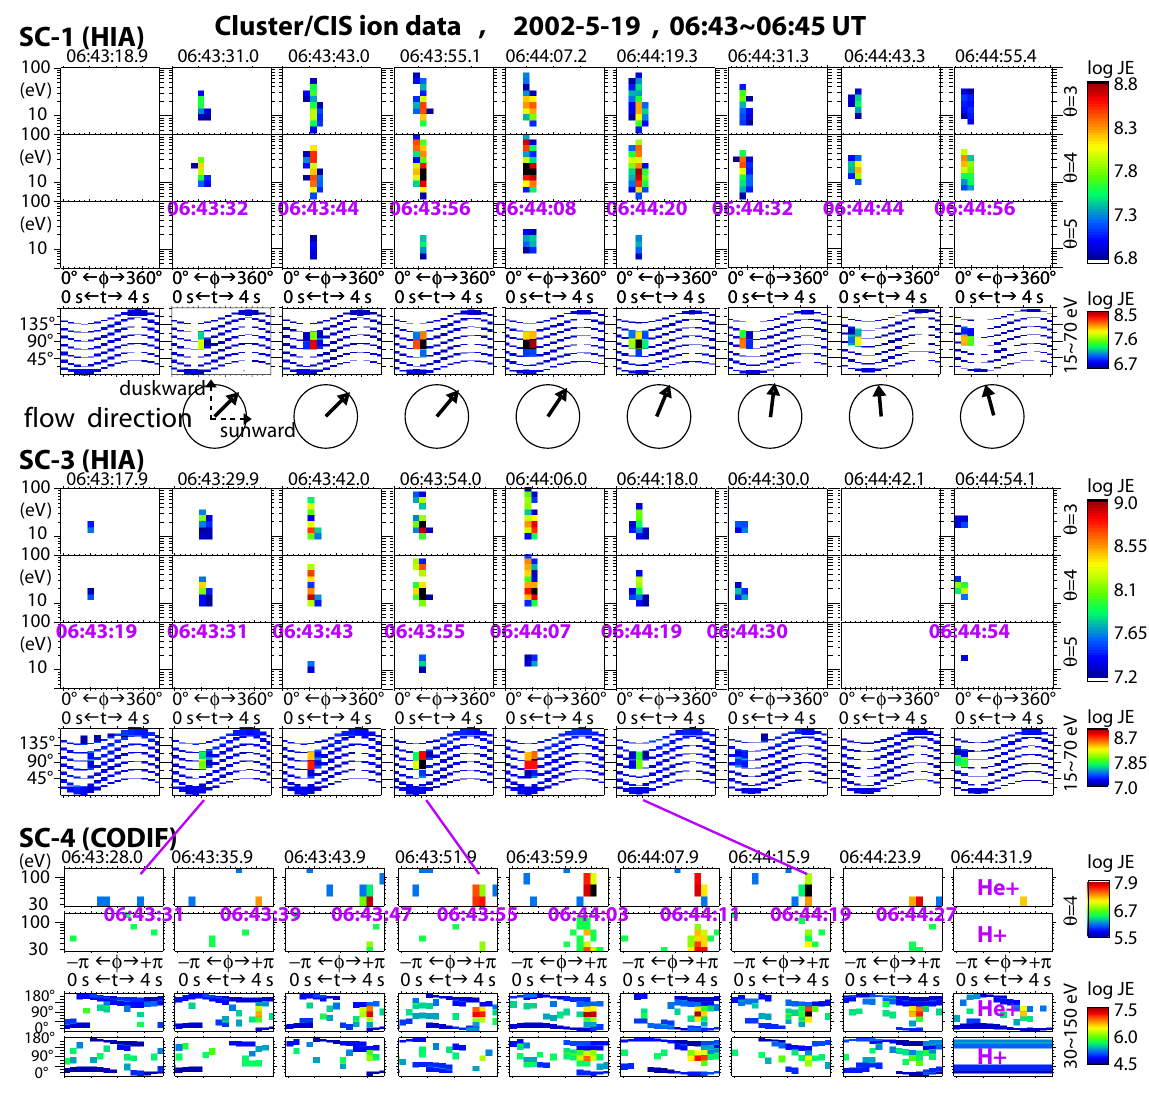
Fig. 7. Highest resolution plots of differential energy fluxes (keVcm − 2 s − 1 str − 1 keV − 1 ) of low-energy ions observed by CIS during data (bottom 4 rows) corresponding to low-energy part of Fig. 1b. Data is not averaged over spin (4s) or different sectors (polar angles). During this period, HIA took data every third full-spin (taking data 4s and idle 8s) for both SC-1 and SC-3, while CODIF took data less frequently except for SC-4 which took data every other full-spin (taking data 4s and idle 4s). For each 4-s measurement, UT corresponds to the spin phase angle (azimuthal angle, which is 180 ◦ off between HIA and CODIF), and the starting UT of each 4-s measurement is displayed at the top of panels for each SC. The top three rows are energy-time spectrograms of 4 ∼ 100eV ions from SC-1 observed at sectors with non-zero flux beyond the noise level (sectors 3, 4, and 5) among total 8 sectors. Sector 1 is looking at nearly north, i.e., detecting ions traveling nearly along the geomagnetic field from north to south. Sectors 4 and 5 correspond to nearly perpendicular direction to the geomagnetic field. The UT under the enhanced counts inside panels corresponds to the UT when these counts are actually detected (in only 2 ∼ 3 directions out of 16 azimuthal directions). The 4th row is energy-averaged (15 ∼ 70eV) pitch angle-time (azimuth) spectrogram, where the blue thick lines denote the direction of boundaries between neighboring sectors (top and bottom sectors corresponds to sectors 1 and 8, respectively). The pitch angle of each sector slightly modulated because the spin axis is not exactly 90 ◦ from the magnetic field direction. The enhanced counts are registered in nearly the same azimuthal direction, and this flowing direction in the geophysical coordinate is illustrated below the 4th row. The middle four rows are the same as the first four rows except they are from SC-3. The last four rows (CODIF data from SC-4) are organized as energy-time spectrograms of 30 ∼ 150eV H + and He + from sector 4 (the sector with most intense counts), and energy-averaged (30 ∼ 150eV) pitch angle-time (azimuth) spectrograms for H + and He + ,